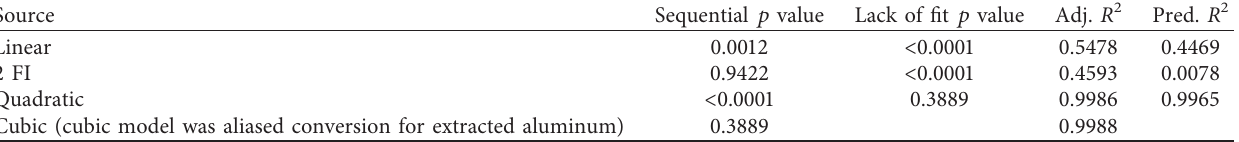
Table 6: Summary of lack of fit and statistical analysis in model selection for extracted aluminum.